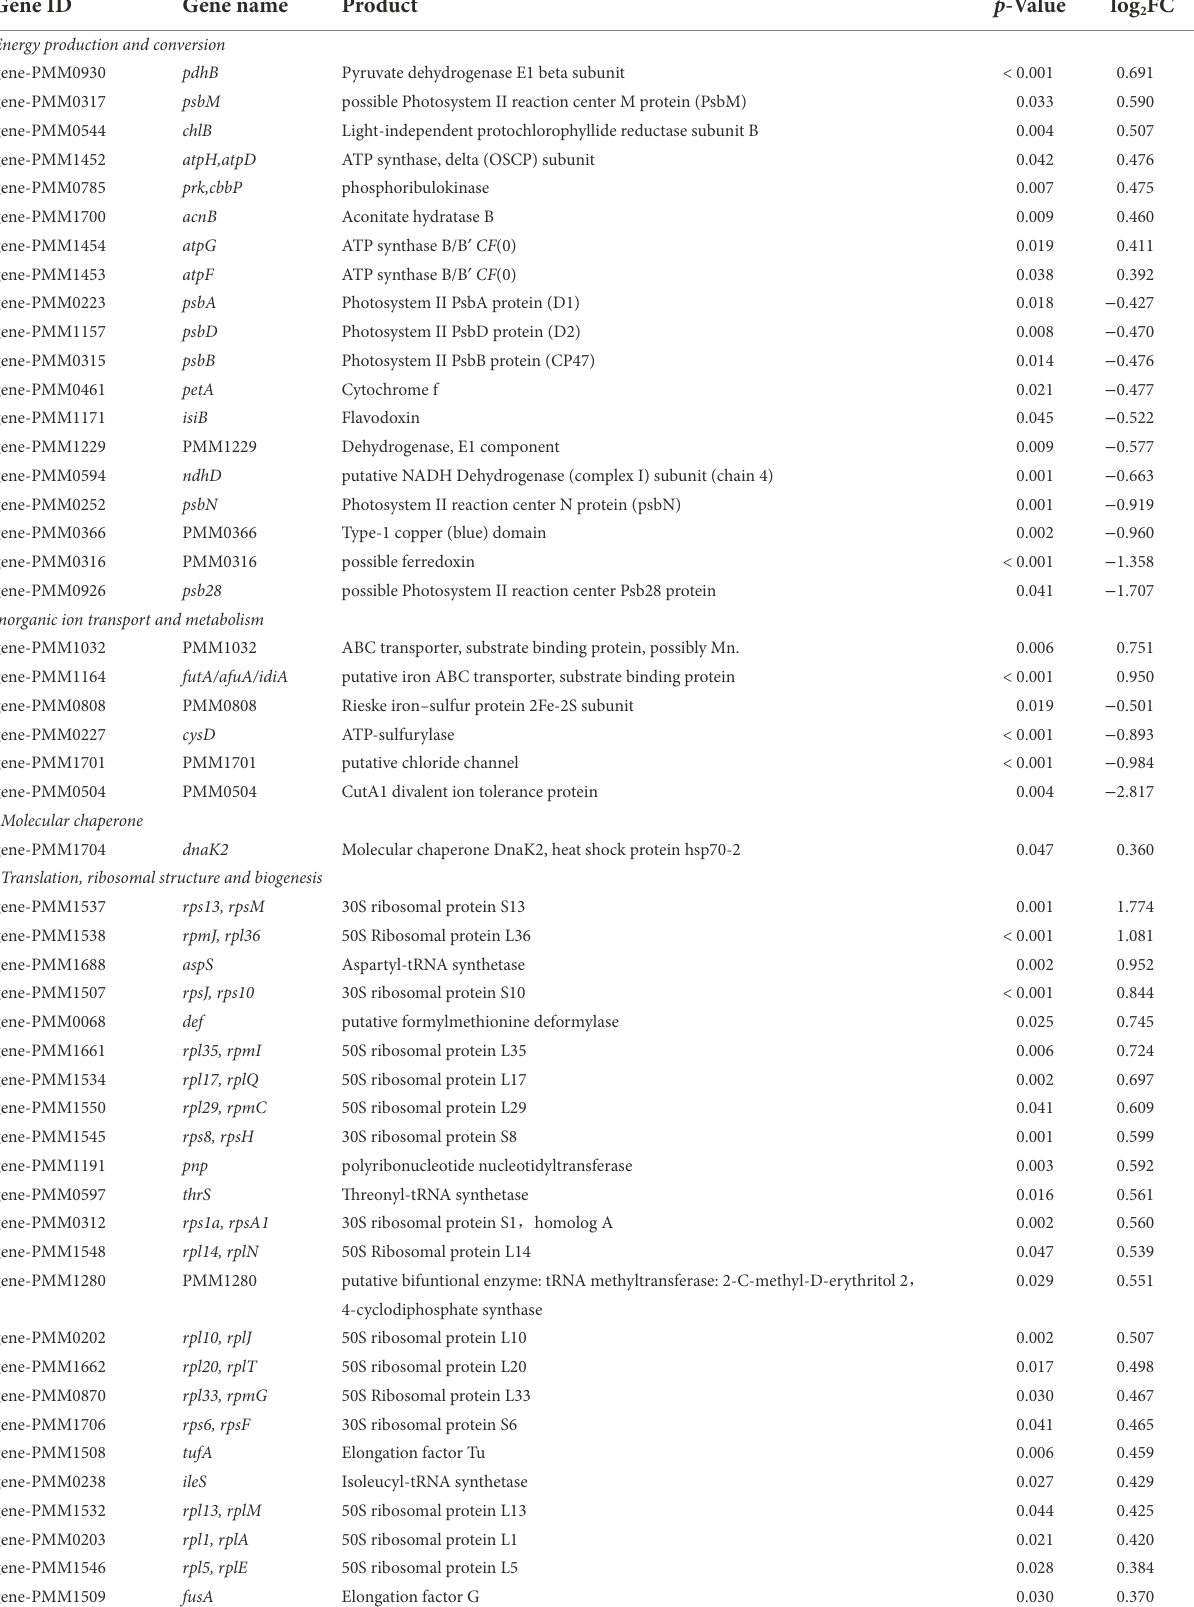
TABLE 3 List of a part of differentially expressed genes ( p < 0.05) in low salinity acclimated Prochlorococcus